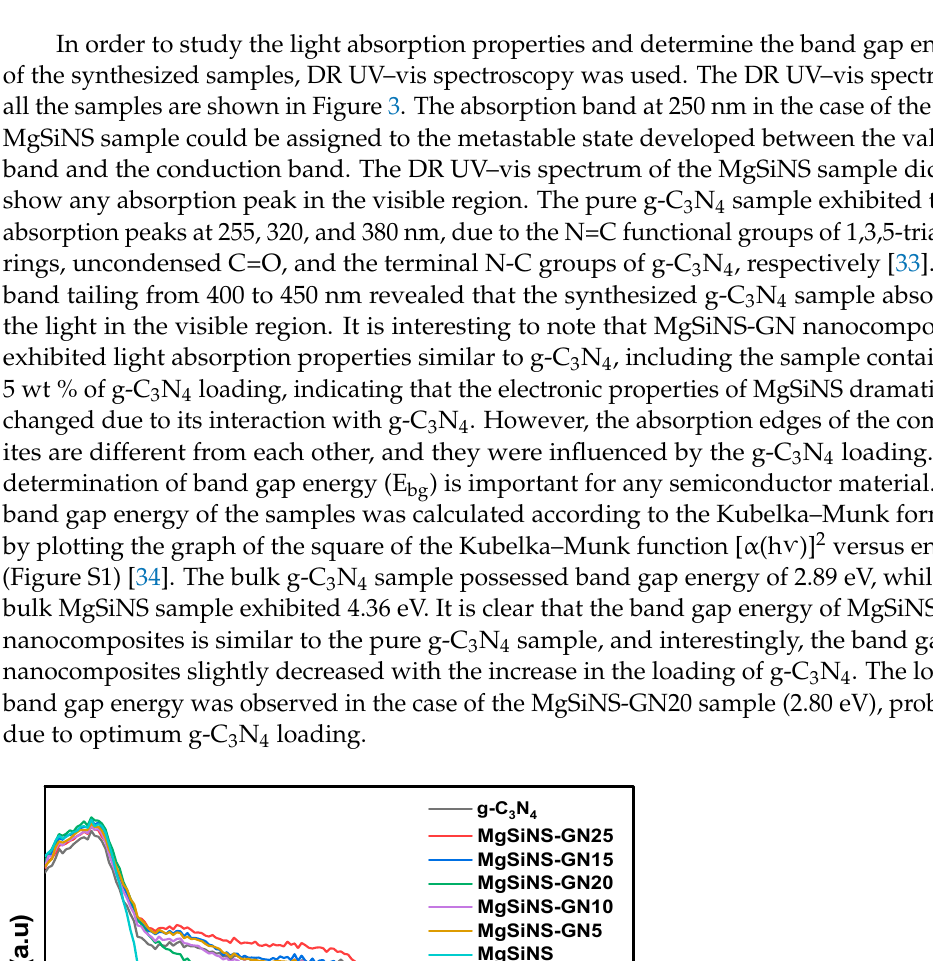
Figure 2. TEM images of MgSiNS, g-C 3 N 4, MgSiNS-GN5, and MgSiNS-GN20 samples.